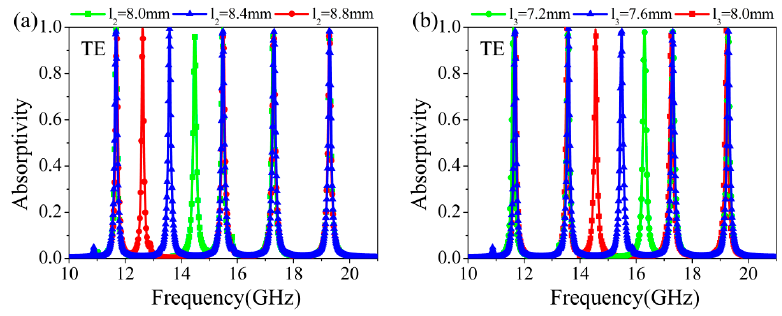
Table 1. Performance comparisons of the proposed absorber with previous